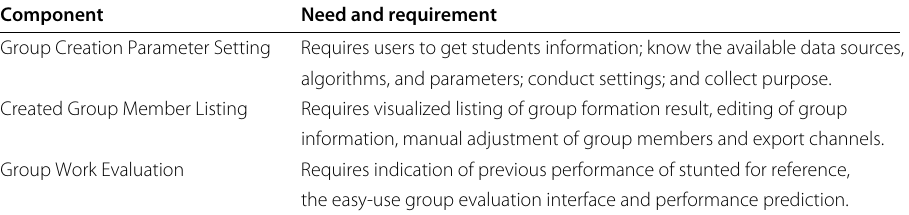
Table 2 General components of group formation and evaluation system Component